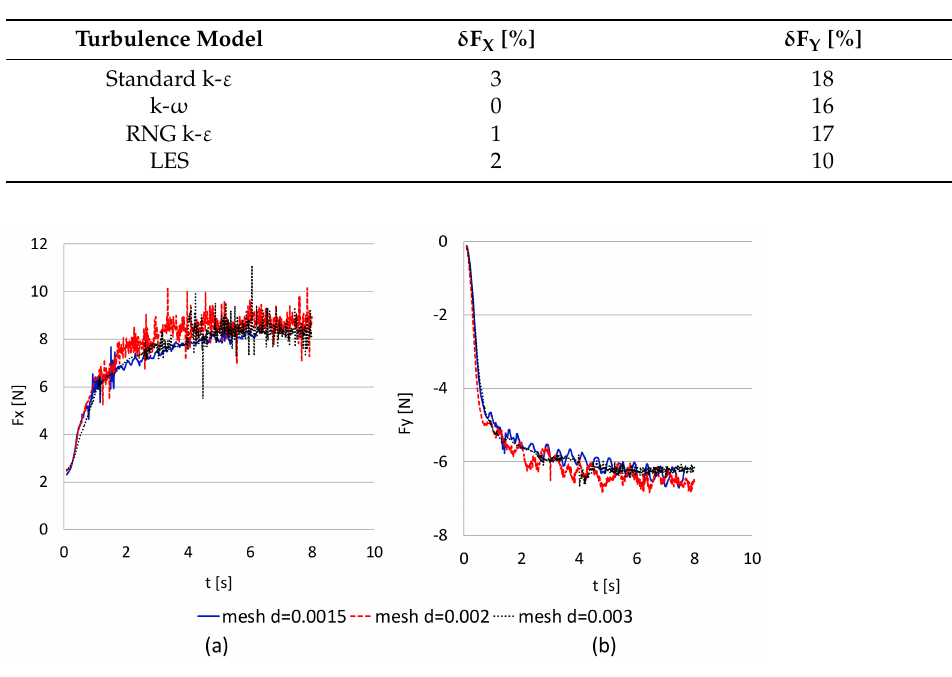
Figure 11. Results of numerical computations in time for the cylinder with D 2 diameter at 500 rpm rotational speed and current speed V = 0.82 m/s using LES model in dependence of mesh density: ( a ) F X and ( b ) F Y .